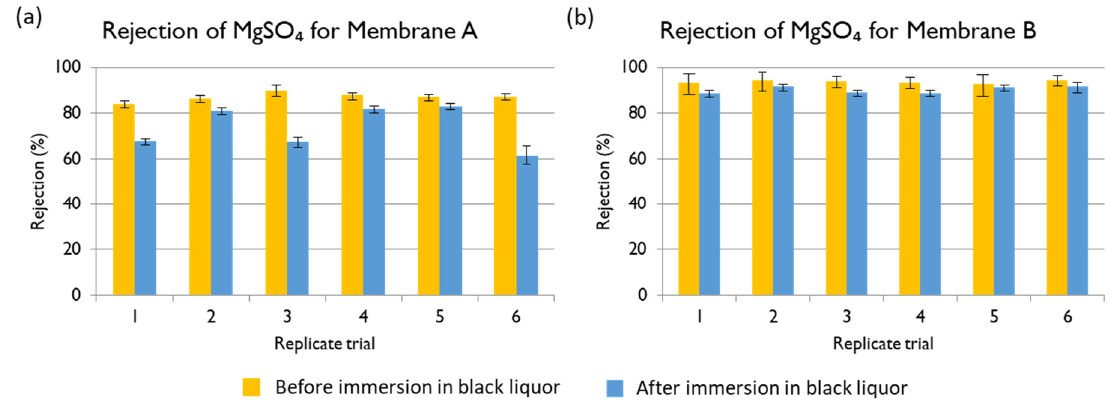
Figure 7. Rejection of MgSO 4 for Membranes A ( a ) and B ( b ) before and after the static test.